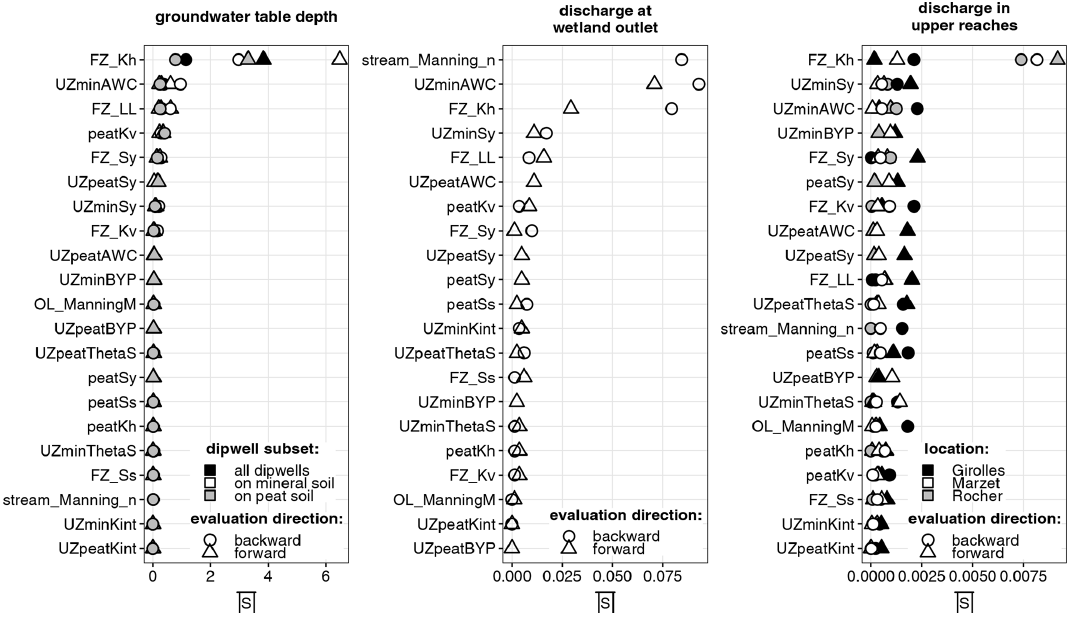
Figure 8. Summary of model sensitivity analysis results (see Table 3 for parameter codes). Parameters are arranged in order of increasing mean sensitivity from bottom to